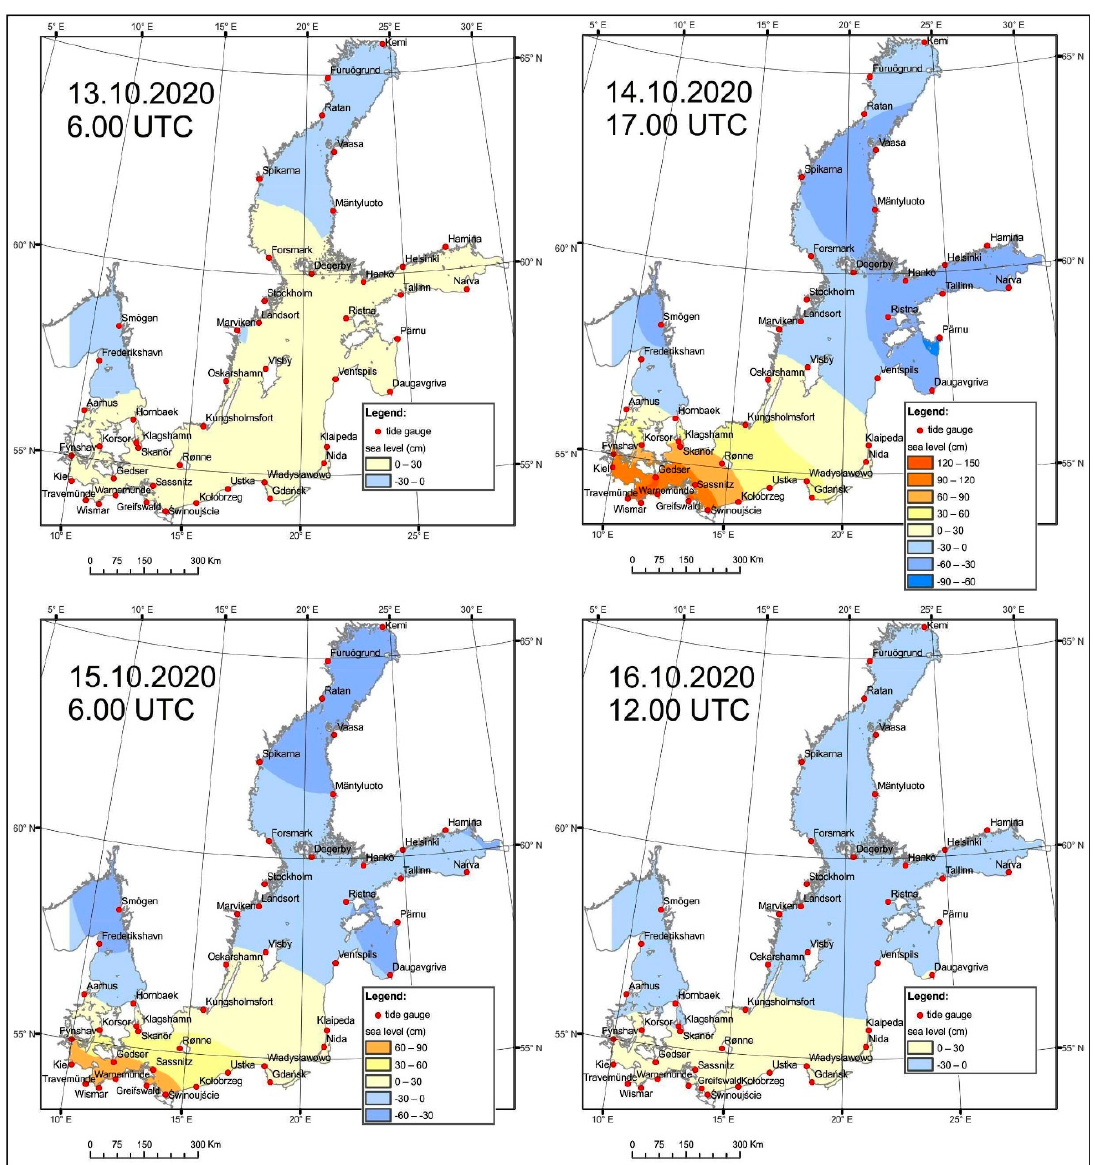
Figure 5. Instantaneous sea levels on the Baltic Sea from 13 to 16 October 2020. ( Storm surge rising and falling in the Western Baltic due to wind impact).